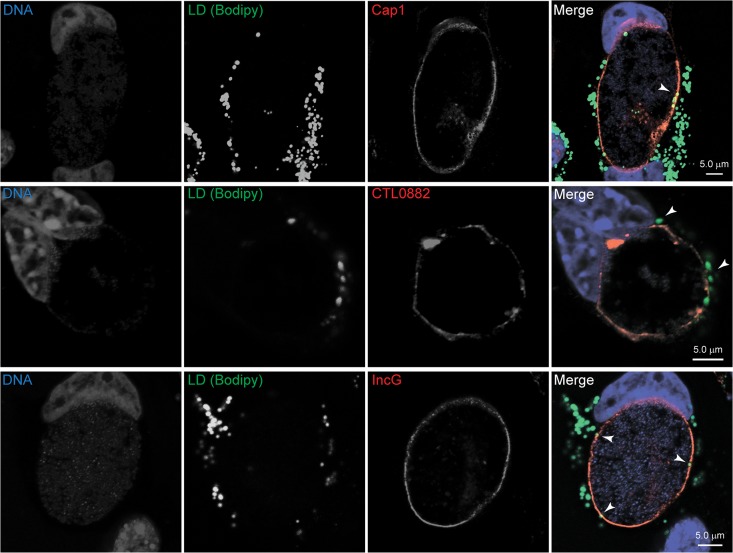
LDs associate with Cap1, CTL0882 and IncG at the inclusion membrane.Representative confocal images of HeLa cells infected with C. trachomatis (40 hpi), stimulated with oleic acid (100 μM, 14h prior to fixation). Immunofluorescence staining of Cap1, CTL0882 and IncG was carried out (red channel) and LDs were visualized using the neutral lipid-specific BODIPY 493/503 staining (green channel). Hoechst staining was used to visualize DNA (blue). Bar sizes are shown in the merge panels. Arrowheads highlight LDs found in close apposition with Cap1, CTL0882 and IncG in the inclusion membrane, as indicated.